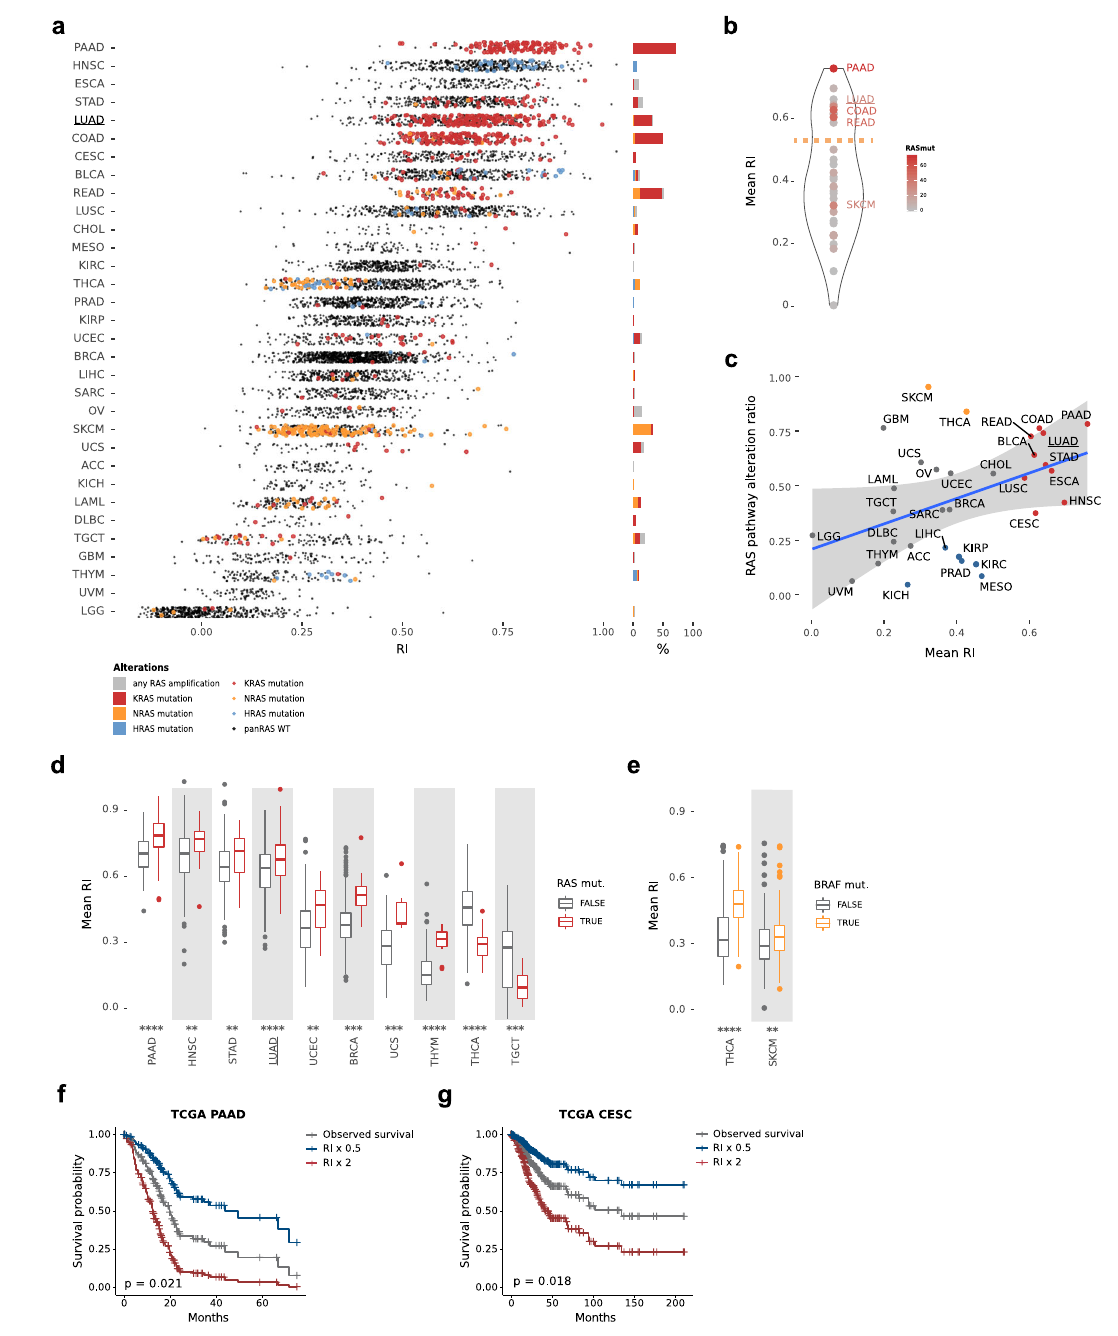
Fig. 6 | RAS Activity Pan-cancer. a RI plotted per patient across the TCGA pan- cancer cohort. RNA-Seq gene counts were VST and z-score normalised per cohort. RAS mutants are highlighted (KRAS in red, HRAS in blue and NRAS in orange). RelativeRASisoformmutationfrequenciespercohortareshowninthebarchartto the right using the same colours. Frequencies of patients with a RAS gene ampli- fi cationbutnomutationareshowningrey. b Aviolinplotshowingthedistribution of mean RI across each TCGA cohort. The dotted orange line indicates the dis- tribution minima separating the two cancer populations. c The ratio of patients with one or more RAS pathway mutations plotted against the mean RI for each cohort.Alinearregression fi tisshowninbluewitha99%con fi denceintervalshown by the grey ribbon (spearman coef fi cient 0.432, p -value 0.014). Highly RAS active tumours are shown in red, BRAF-driven tumours in orange and tumours with a RI valuebelowthelower99%CIareshowninblue. d